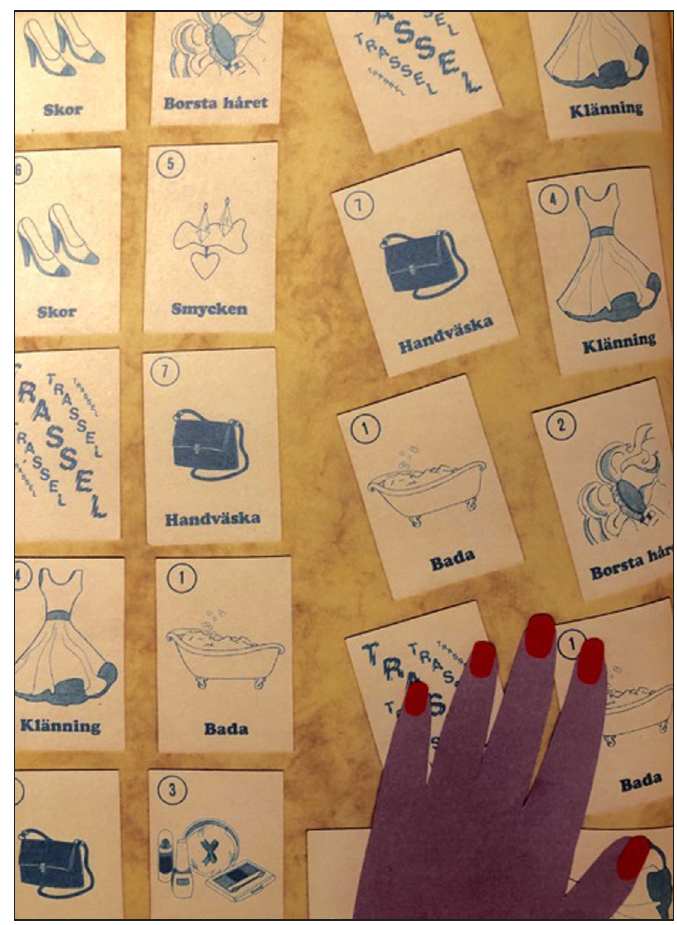
Figure 5: Lisa Ewald (2017) Måste carpa. Stockholm: Galago. © Lisa